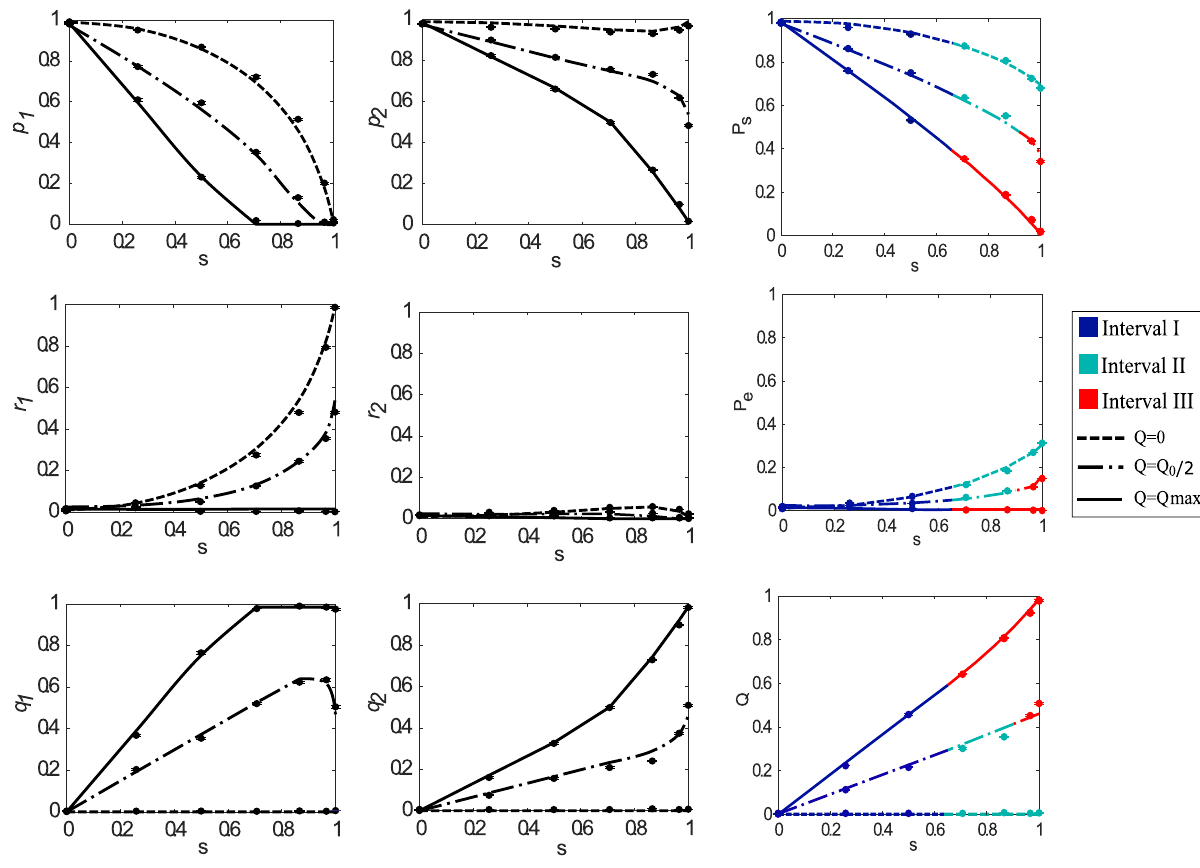
Figure 3. The success P s ( p i ), error P e ( r i ) and inconclusive Q ( q i ) probabilities as a function of the inner product s for preparation probabilities given by η 1 represents the corresponding probabilities for the state in Eq. (8). Note that the curves in the first and second columns differ due to the preparation probabilities satisfying η 1 discriminate blue, green, and red